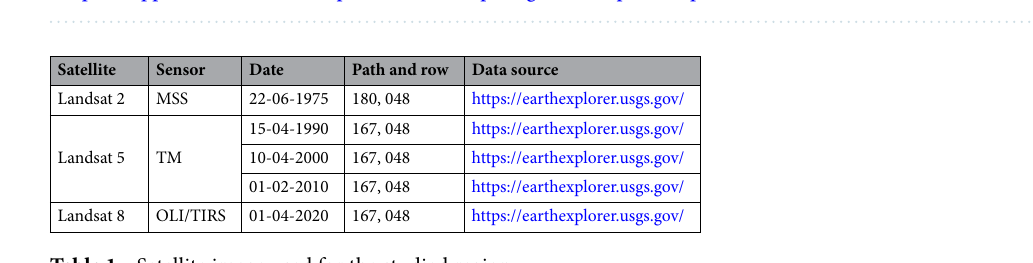
Figure 1. The location map of the studied Farasan Islands, Saudi Arabia 31,32 . Saudi Arabia boundary data was downloaded from DIVA-GIS website (https:// www. diva- gis. org/). The satellite data was downloaded from USGS earth explorer (https:// earth explo rer. usgs. gov/). The map was generated using ArcGIS software, version 10.6 (https:// suppo rt. esri. com/ zh- cn/ produ cts/ deskt op/ arcgis- deskt op/ arcmap/ 10-6-1).